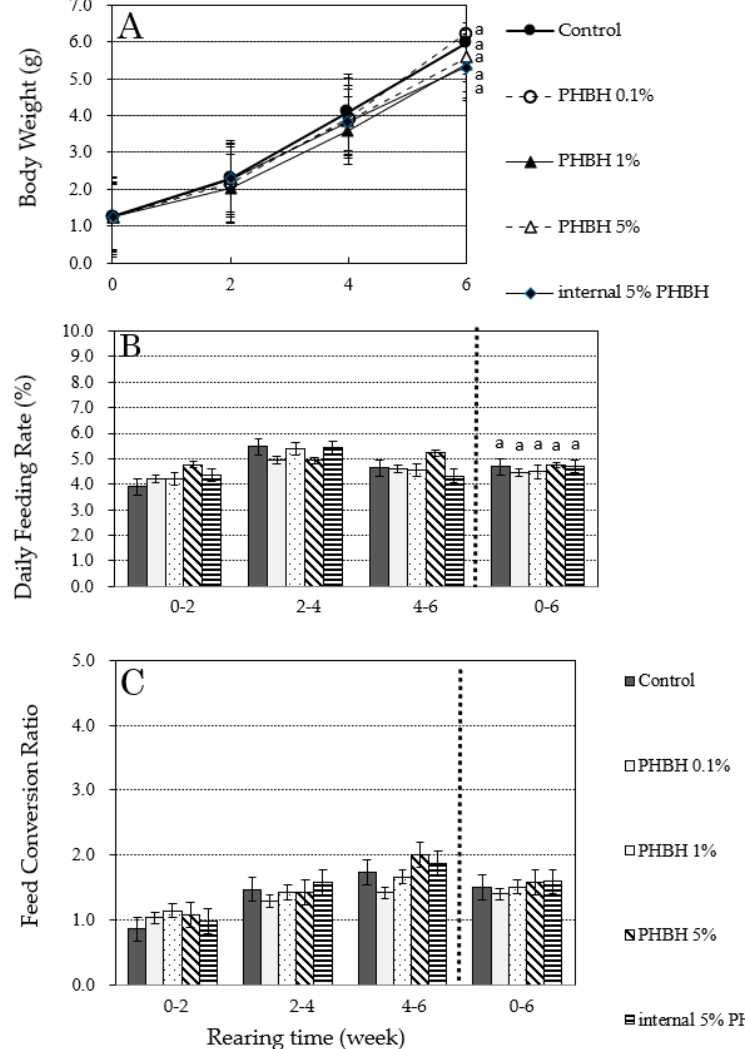
Figure 3. Increases in body weight ( A ) and changes in daily feeding rate ( B ) and feed conversion ratio ( C ) of Marsupenaeus japonicus during a 6-week feeding test with feed containing different amounts of poly-hydroxybutyrate-co-hydroxyhexanoate (PHBH). Different superscript letters show significant differences ( p < 0.05).